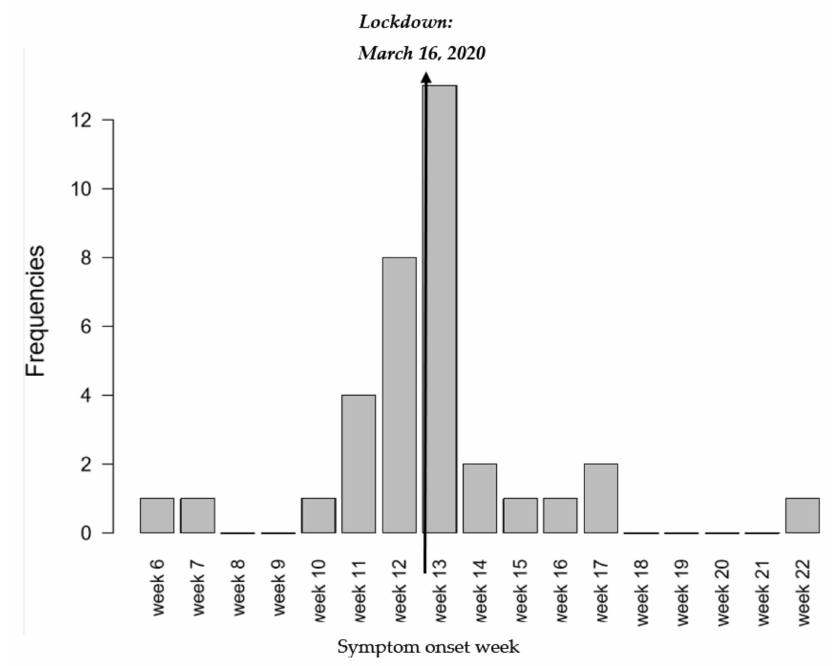
Figure 4. Date of onset of symptoms in seropositive symptomatic individuals ( n =